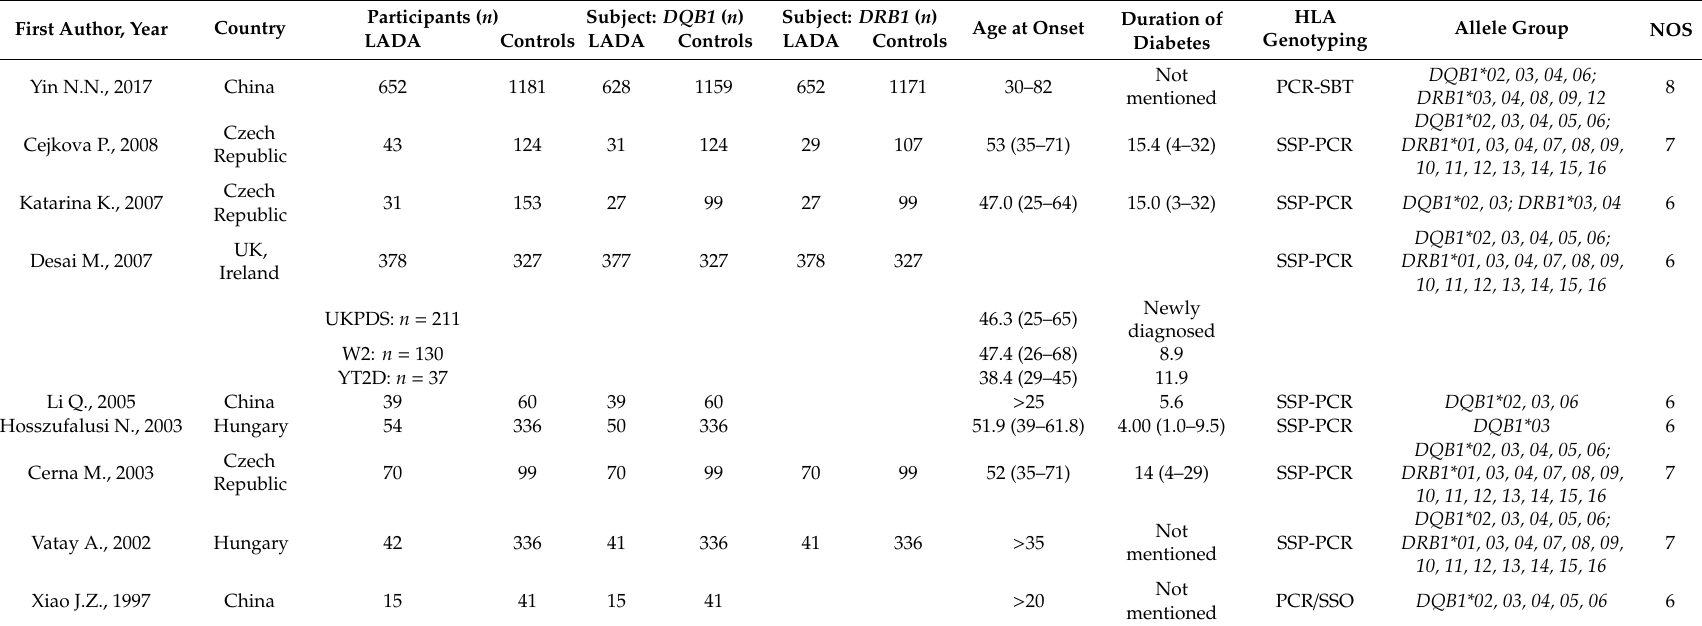
Table 1. Summary characteristics of the studies included in the